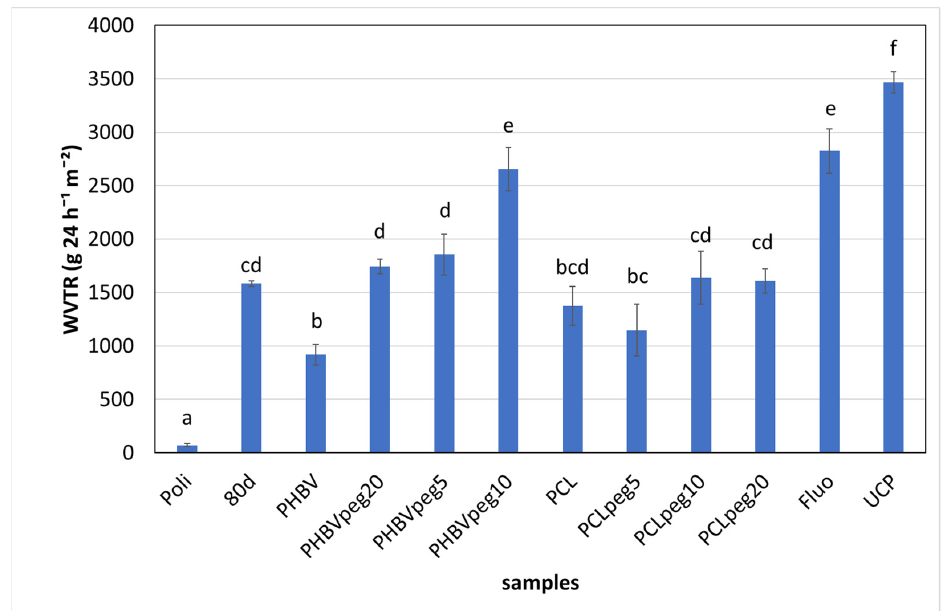
Figure 6. WVTR values (g 24 h − 1 m − 2 ) of PHBV and PCL coated samples both pure and with PEG addition at different concentrations (set 2). Bars represents the average value of three determinations, error bars report standard deviation. Different letters indicate statistically significant differences ( p < 0.05). “UCP” refers to base paper, “Fluo” to fluorinated paper, while “Poli” to polyethylene- coated paper. See Table 1 for other samples